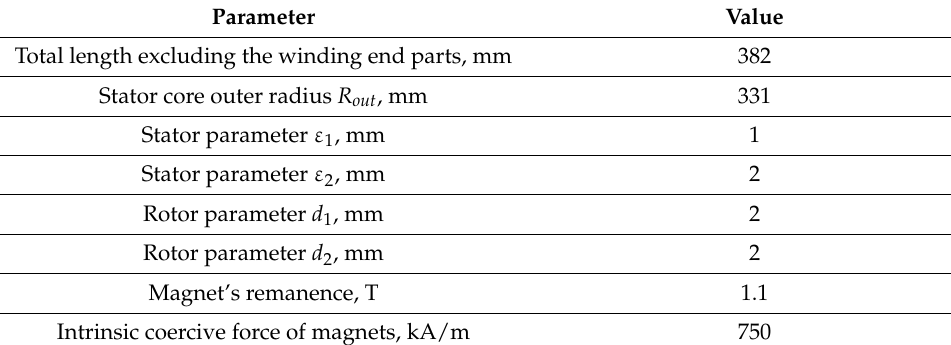
Table 2. IPMSM parameters fixed during the optimization.